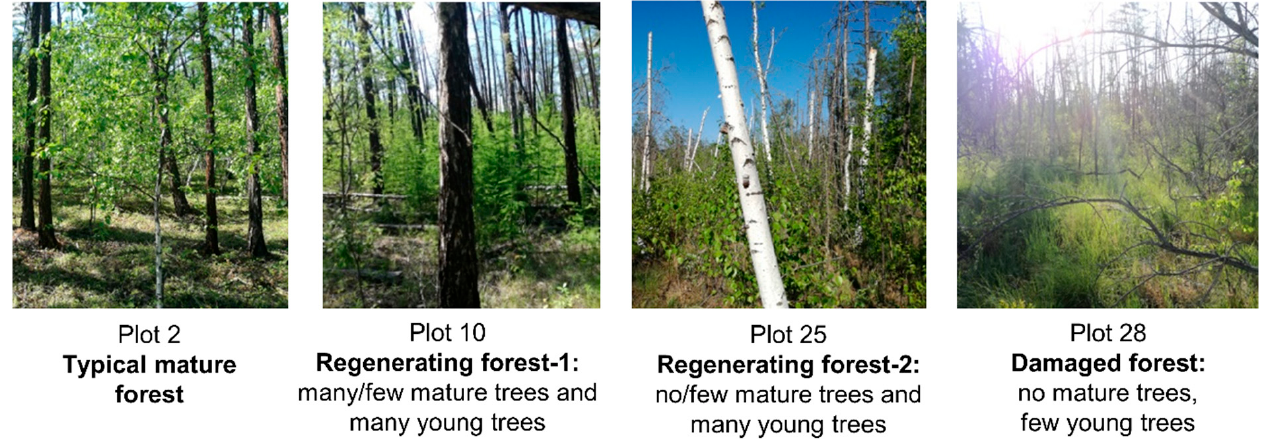
Figure 2. Four larch forest types on damage levels observed along the transect: typical mature forest (TF), two types of regenerating forest (RF-1 and RF-2), and damaged forest (DF). Each forest type is demonstrated as a photograph taken at a representative plot.